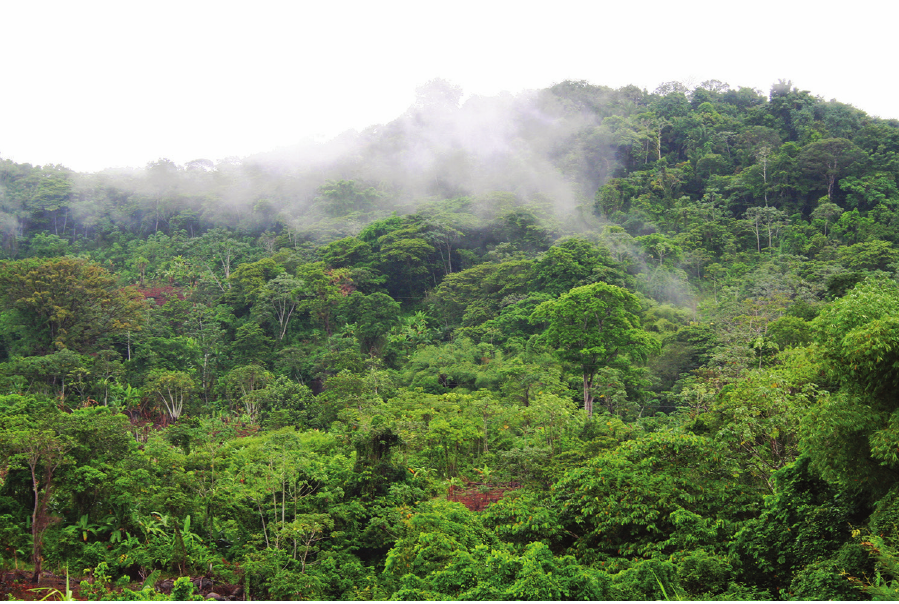
Figure 35. Altitude tropical rainforest habitat (Saül, French